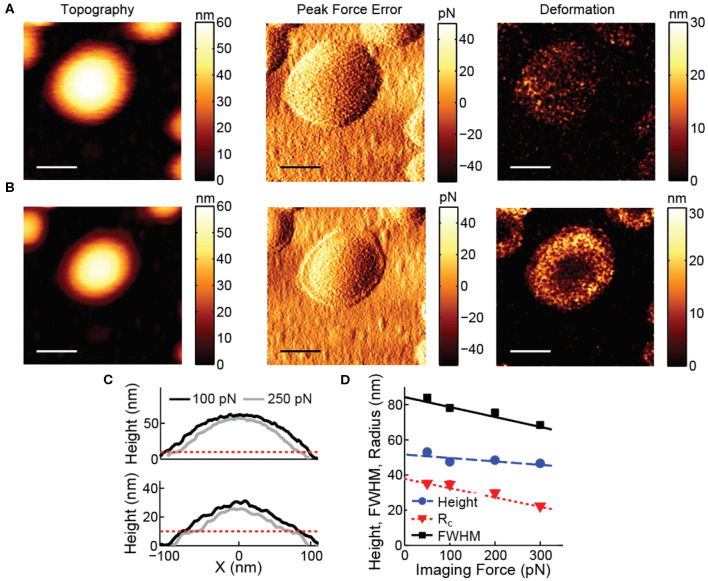
Effect of imaging force on vesicle images. (A) Topography, peak force error and deformation image recorded at 100 pN. (B) Topography, peak force error and deformation image recorded at 250 pN. All scale bars are 100 nm. (C) Comparison of line profiles through the maximum of the vesicles recorded at 100 and 250 pN. The dashed red line indicates the approximate height expected for a double lipid bilayer (~10 nm). Upper panel corresponds to the data in (A,B). (D) Height, radius of curvature and full width at half maximum (FWHM) of liposomes recorded at various imaging forces. At least 180 particles were analyzed for each condition; error bars indicating standard error of the mean fall within the marker size. Lines show linear fits with slopes:−0.020 (Height), −0.056 (FWHM) and −0.053 (Rc).